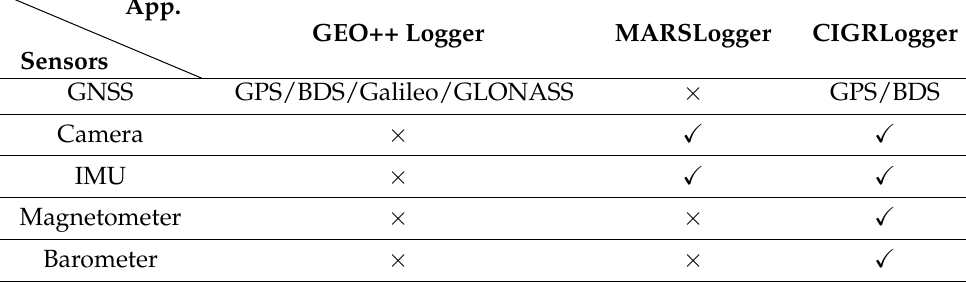
Table 3. The comparison of GEO++ RINEX Logger, MARSLogger, and CIGRLogger. App. Sensors